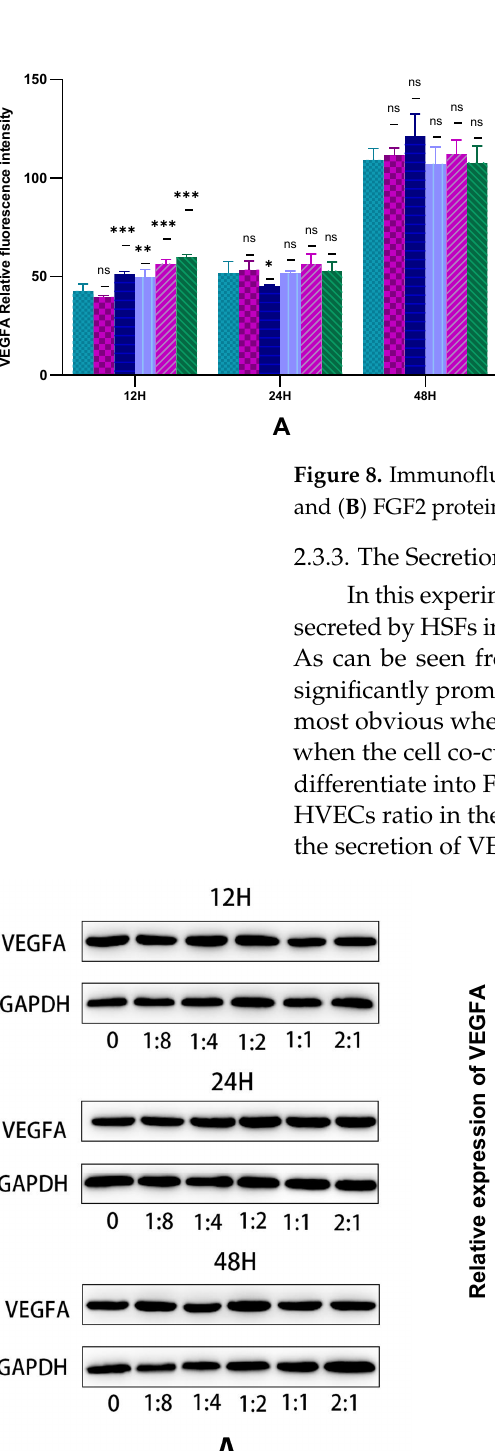
Figure 7. The immunofluorescence staining map of VEGFA and FGF2 proteins secreted by HSFs in the cell co-culture system. ( A ) The immunofluorescence staining of VEGFA protein secreted by HSFs after cell co-culture for 12 h. ( B ) The immunofluorescence staining of FGF2 protein secreted by HSFs after cell co-culture for 12 h. Scale bar: 100 μm.